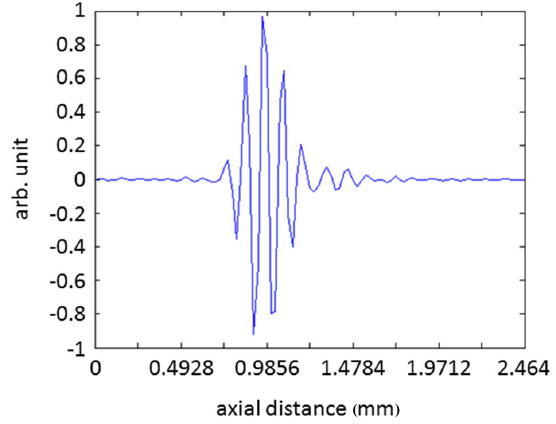
Figure 9. Beamformed radio-frequency (RF) signal obtained along a scan line, which passes through the peak of the point spread function shown in Figure 3.